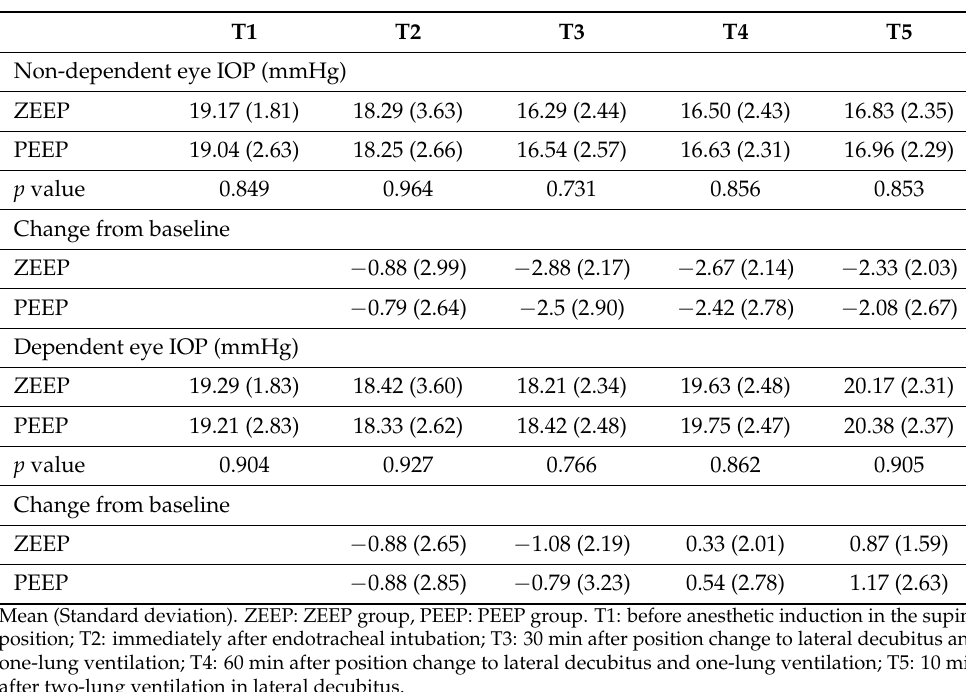
Table 3. Comparisons of intraocular pressure (IOP) values between the study groups.